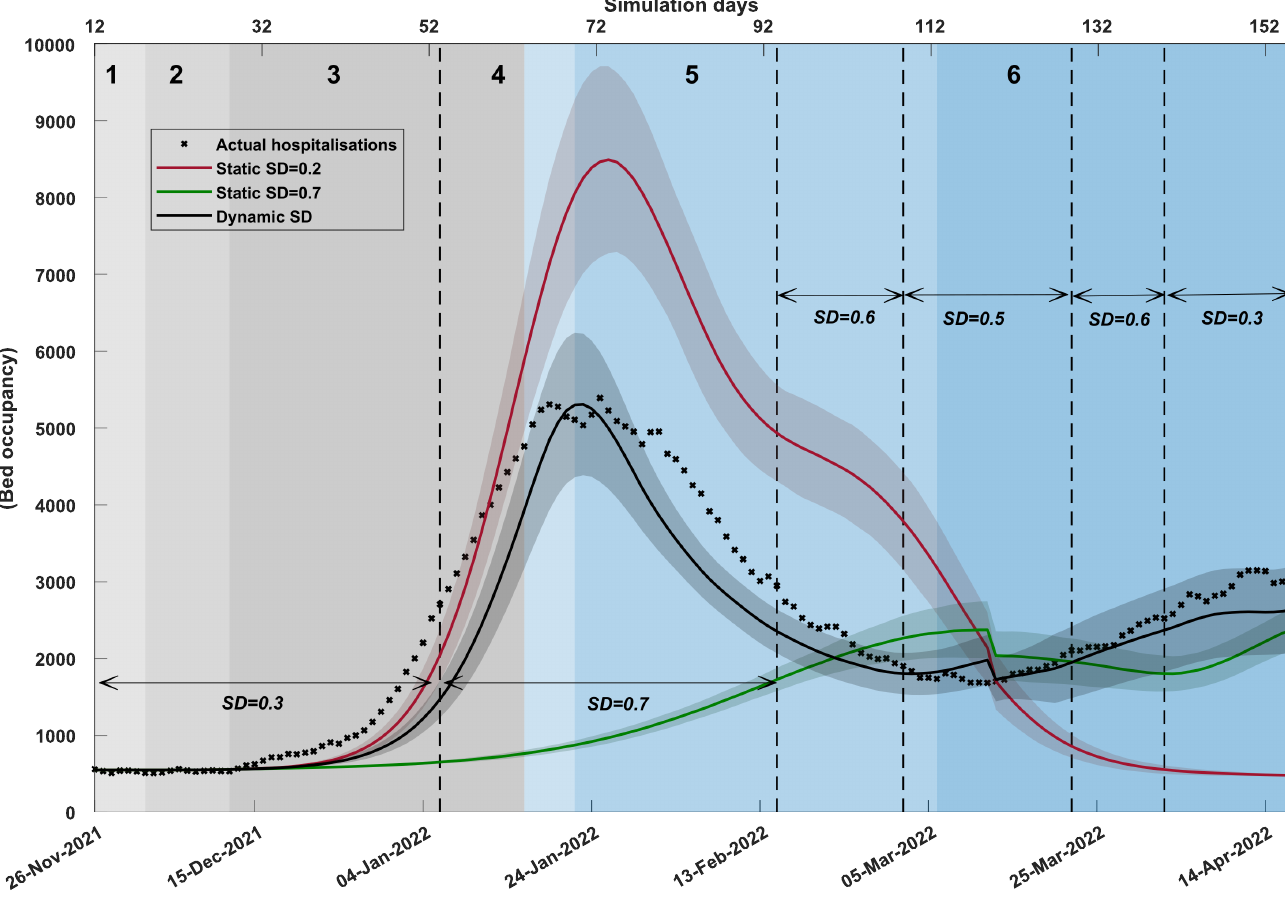
Fig 3. A comparison of hospitalisations (bed occupancy) produced by different social distancing (SD) profiles. The plot contrasts dynamic social distancing (SD) levels (shown in solid black) and static SD levels ( SD 1 = 0.2, shown in red; SD 2 = 0.7, shown in green). The simulated hospitalisations are offset by 7 days. Coloured shaded areas around the solid line show standard deviation. Changes in dynamic SD-adoption are marked by vertical dashed black lines. Traces corresponding to each simulated scenario are computed as the average over 20 runs. SD adoption is combined with other interventions (i.e., school closures, case isolation, and home quarantine). The actual time series (black crosses), shown from 26th November 2021, aligns with the start of the Omicron outbreak in Australia. Shaded areas in grey and blue show the emergence of variants of concern and sub-lineages over time, identified in weekly genomic surveillance reports (NSW Health).